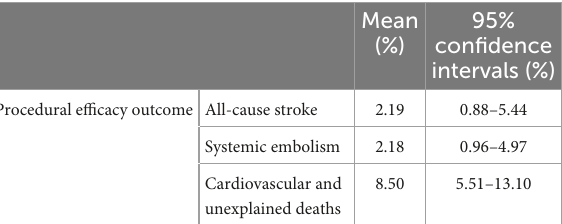
TABLE 3 Subgroup analyses of procedural efficacy outcome.